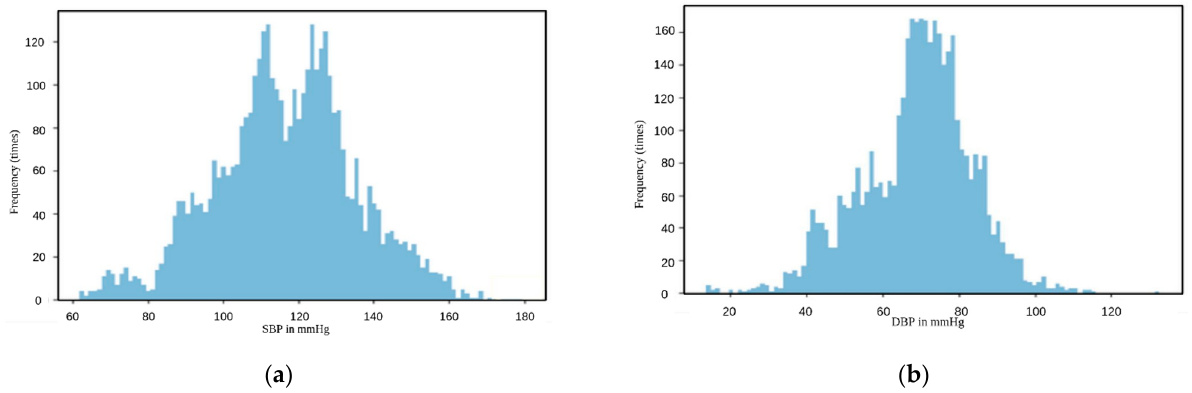
Figure 1. Distribution of the samples before upsampling: ( a ) distribution of SBP samples before upsampling; ( b ) distribution of DBP samples before upsampling.